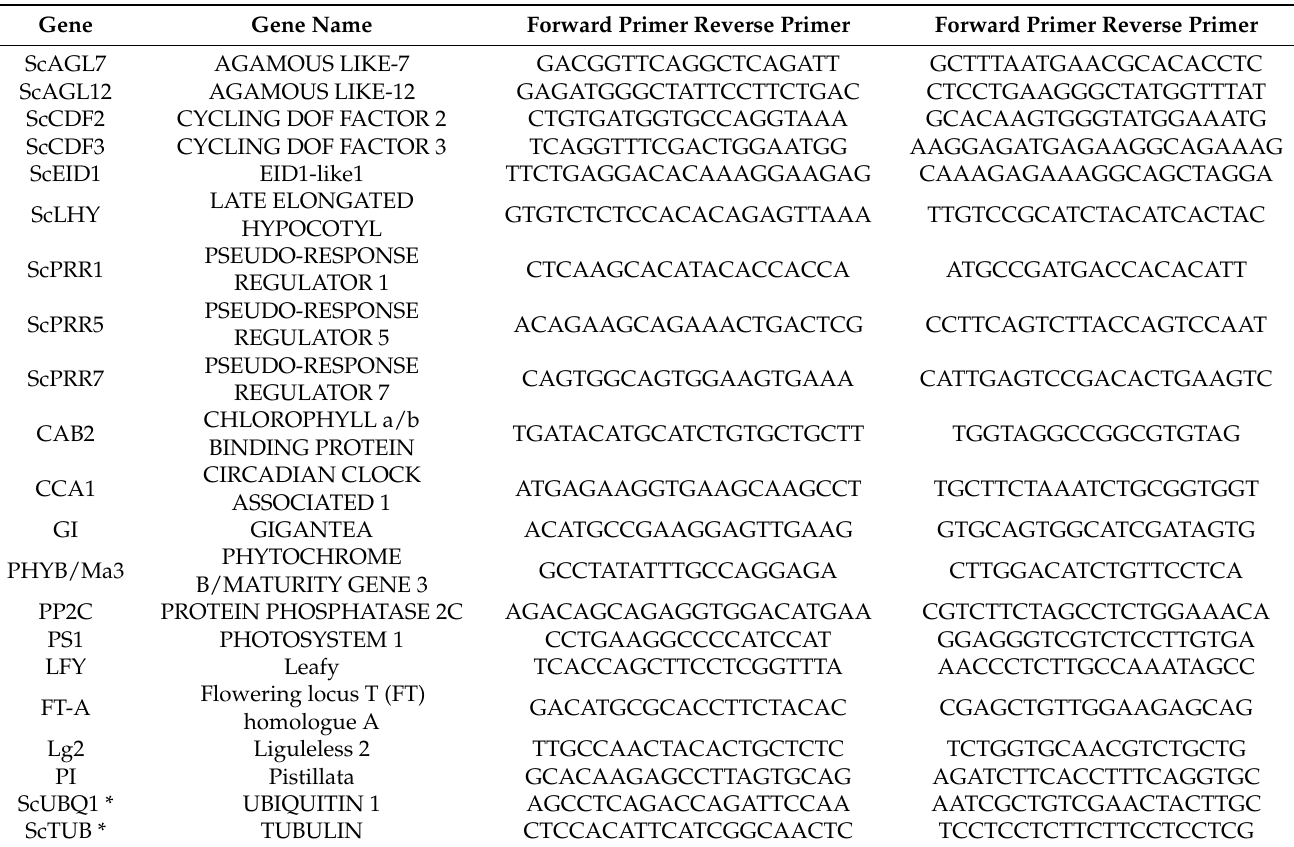
Table 1. Sugarcane putative flowering-related genes selected for gene expression analysis by RT-qPCR using sugarcane tissues collected at the beginning of smut symptom and flowering